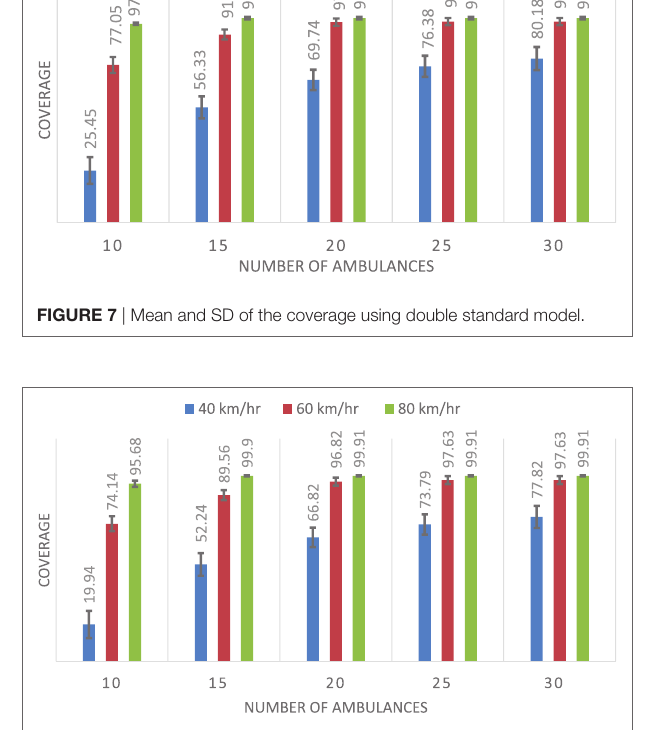
FigUre 8 | Mean and SD of the coverage using double standard model with triangular fuzzy